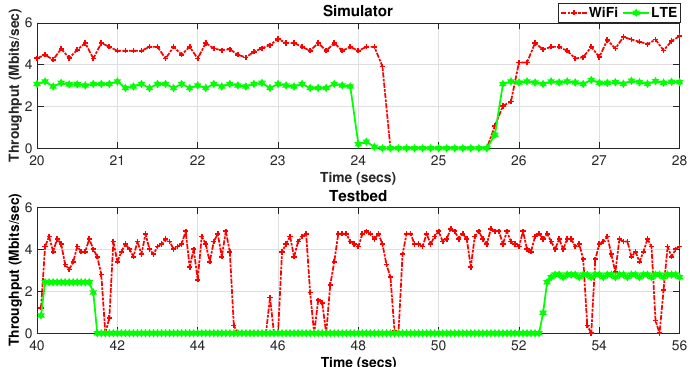
Figure 16. Setup 1 Wi-Fi/LTE subflow throughput variation with time during handover occurrence.